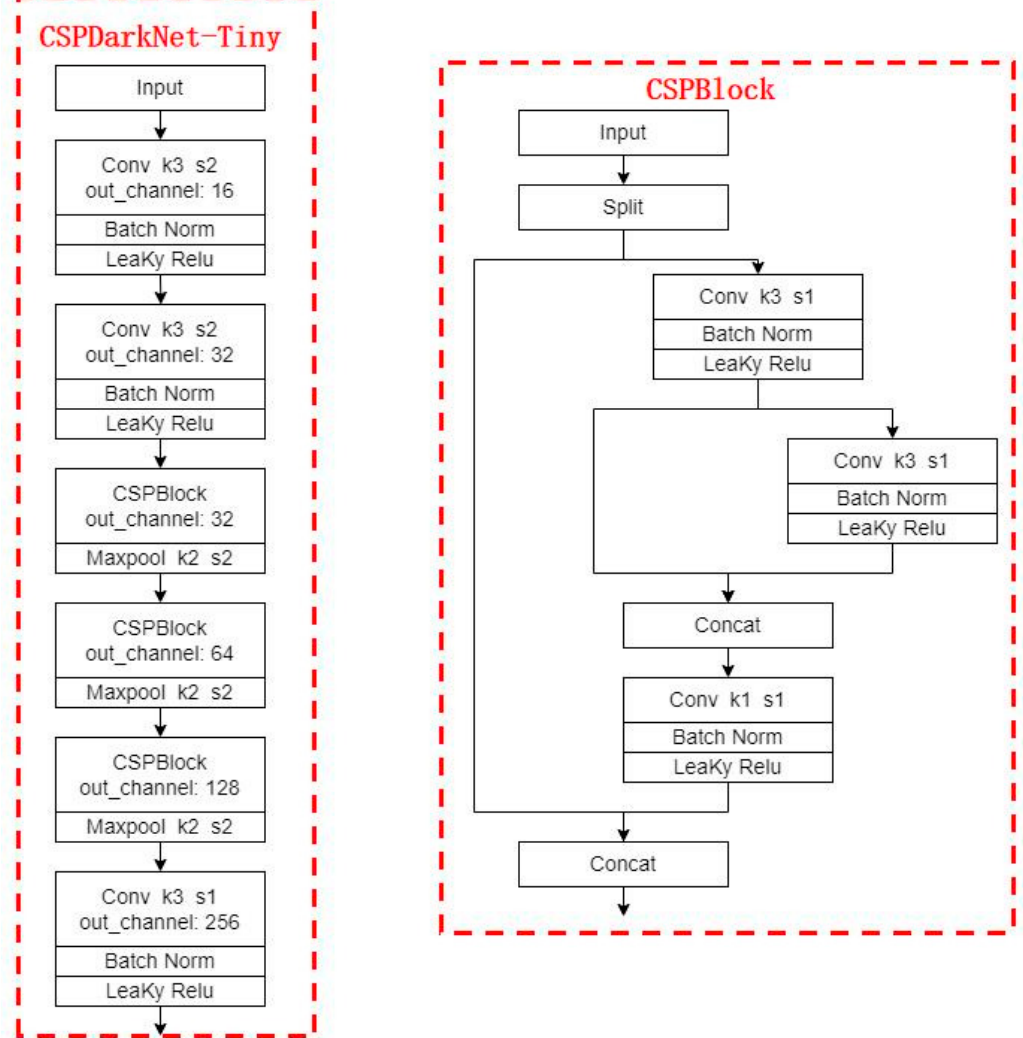
Figure 4. CSPDarkNet-Tiny network structure.